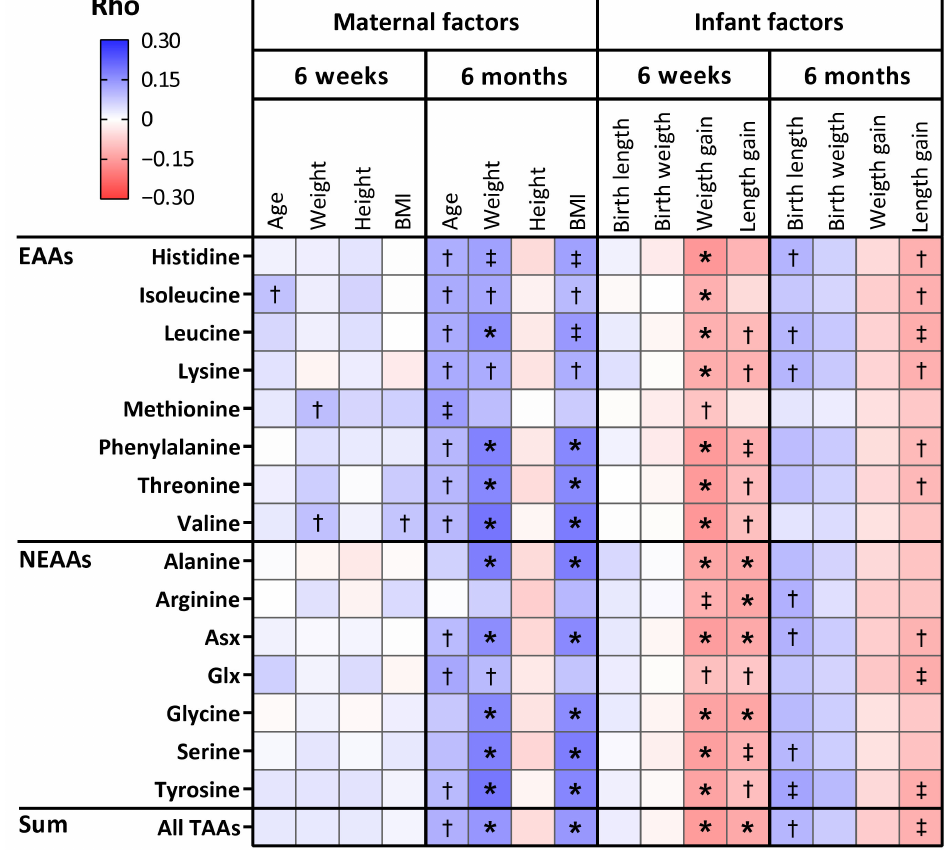
Figure 4. Heatmap of correlations of total amino acids (TAAs) in human milk with maternal and infant anthropometrics. Colouring reflects direction and magnitude of the Spearman correlation coefficients. EAA: essential amino acid; NEAA: non-essential amino acid; Glx: glutamate + glutamine; Asx: aspartate + asparagine; BMI: body mass index. † p < 0.05, ‡ p < 0.01, * p -value remains